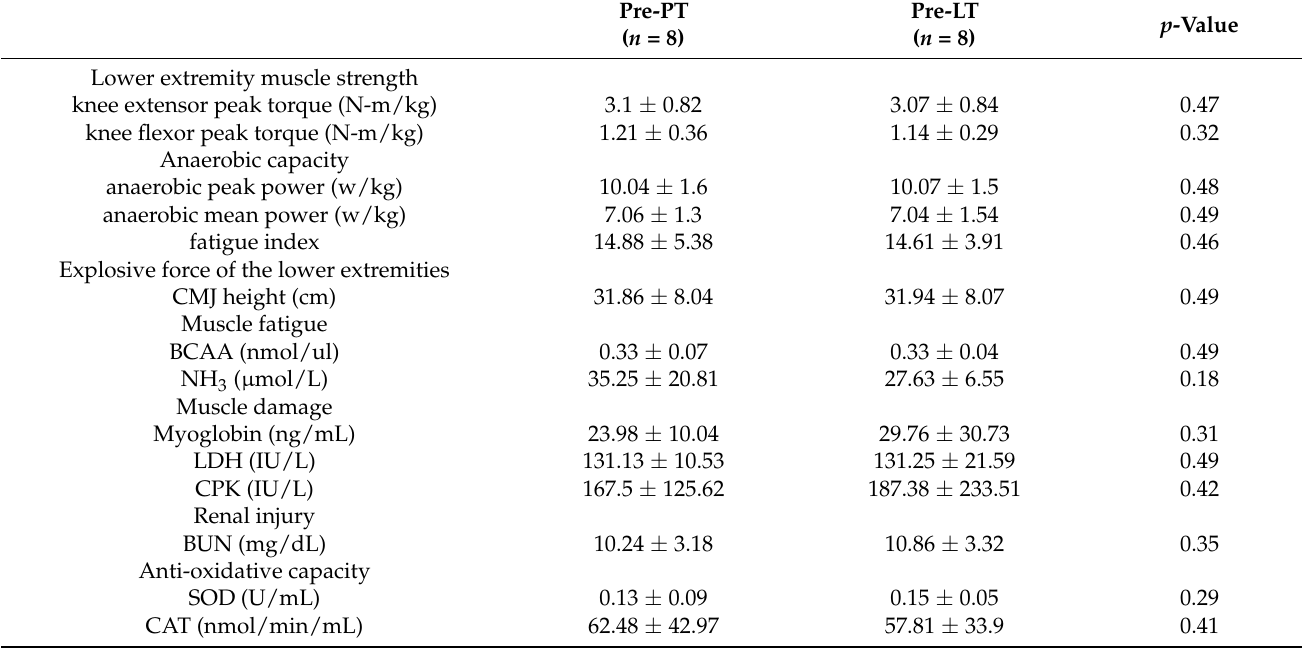
Table 2. Comparison of exercise capacity and blood test between PT and LT after taking nutritional supplements for 4